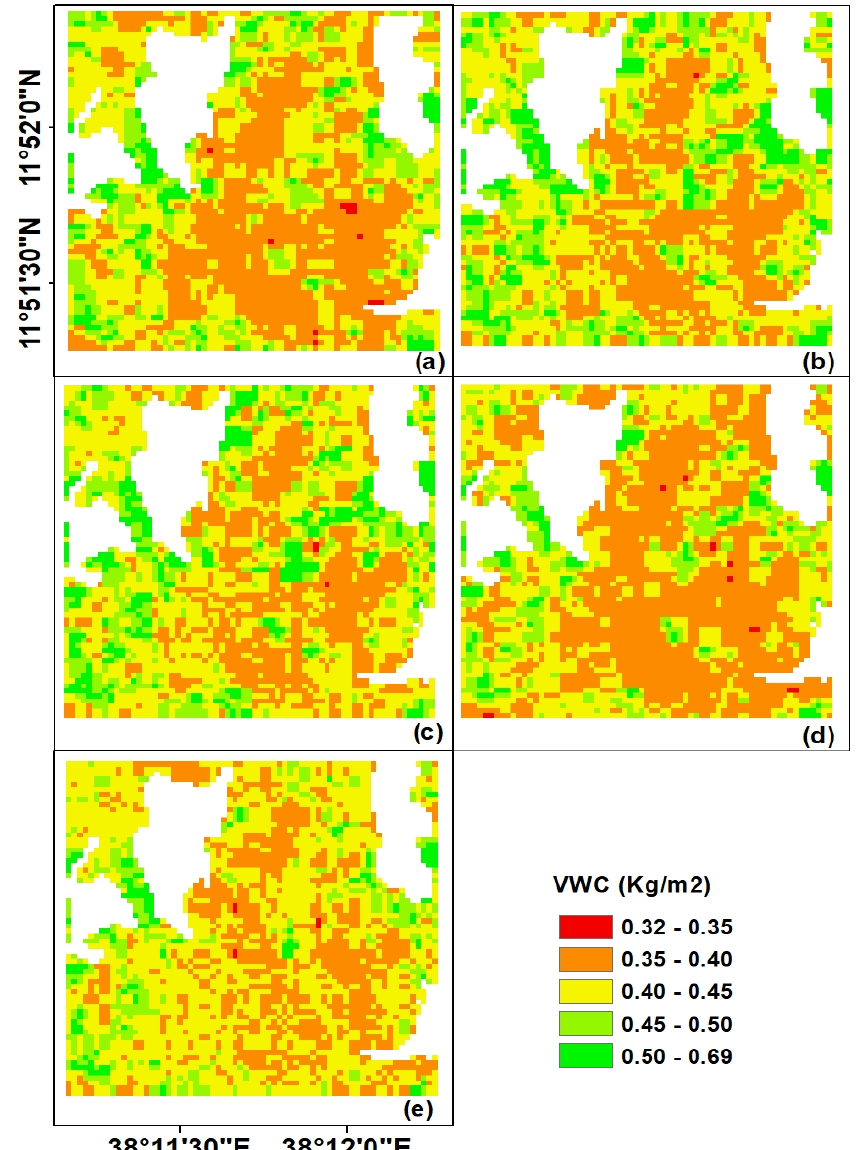
Figure 5. Vegetation water content ( VWC ) maps of the study site derived based on Landsat satellite data: ( a ) 22 November 2016, ( b ) 29 November 2016, ( c ) 16 December 2016, ( d ) 23 December 2016, and ( d ) 2 February 2017.